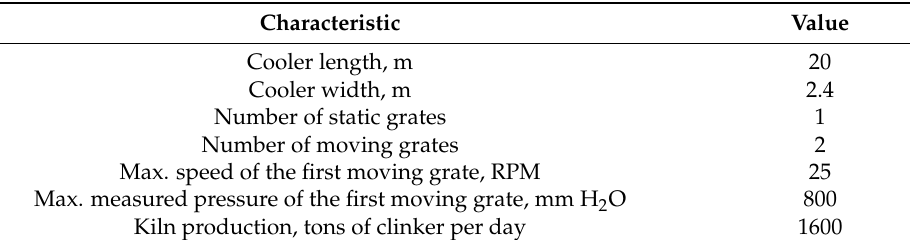
Table 1. Cooler characteristics.